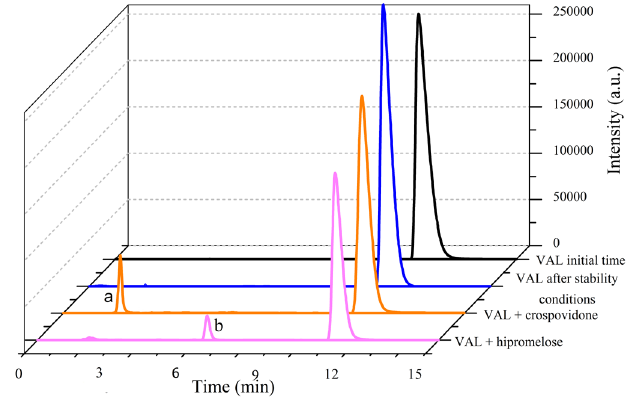
FIGURE 6 - HPLC chromatograms of VAL in binary mixtures with crospovidone and hypromellose (a and b are degradation